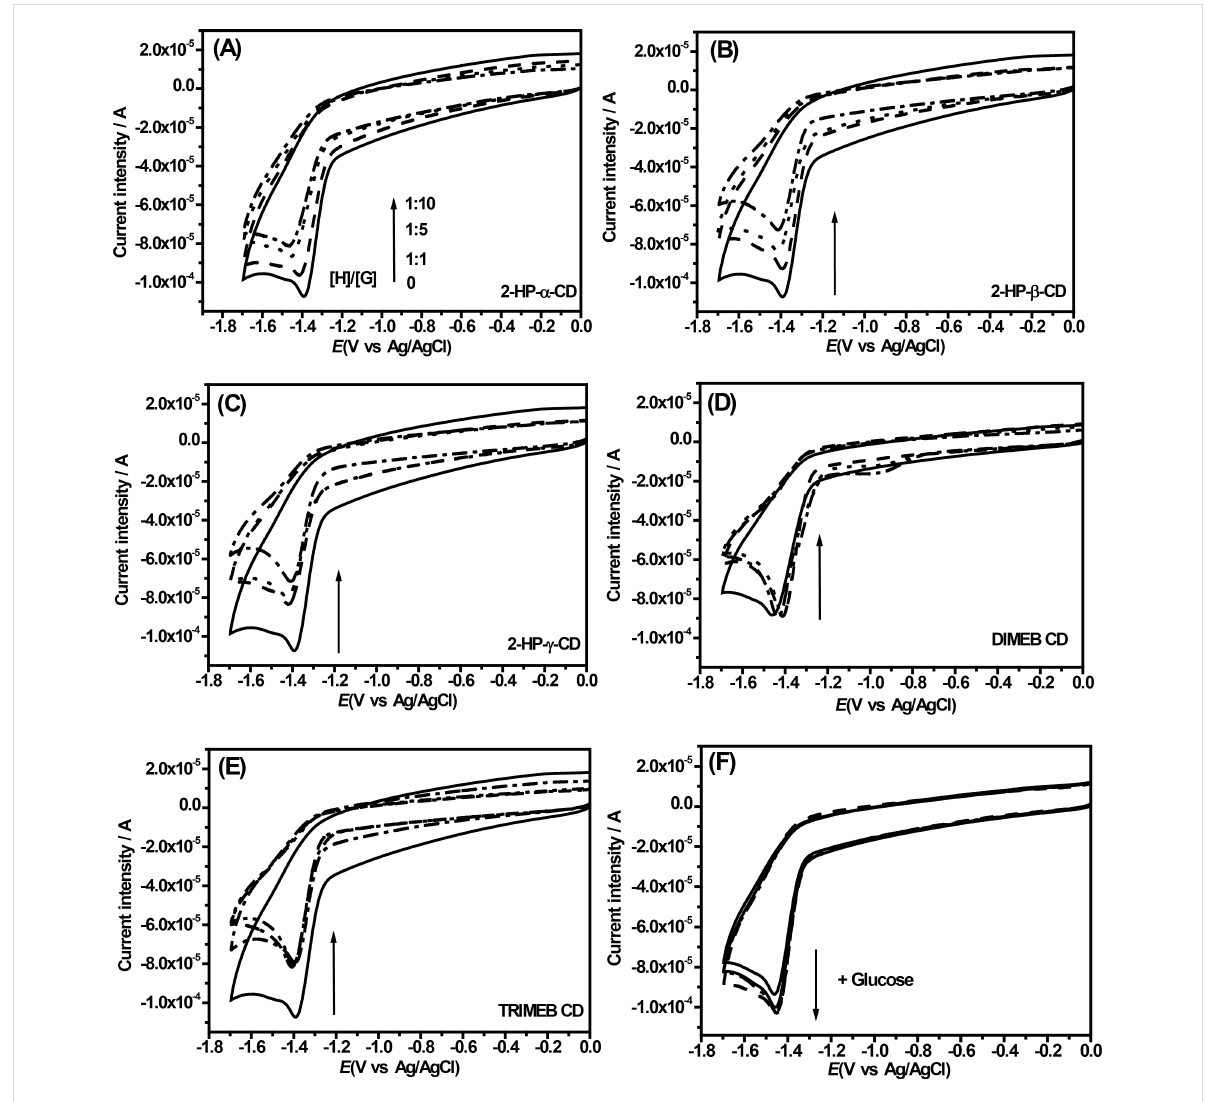
Figure 3: Cyclic voltammetry of aqueous solutions containing S 4 TdR (black solid line) in presence of increasing amounts of CDs, i.e., at molar ratios S 4 TdR/CDs of 1:1, 1:5, 1:10. Supporting electrolyte, LiClO 4 at 0.1 M. (A) S 4 TdR/2-HP- α -CD, (B) S 4 TdR/2-HP- β -CD, (C) S 4 TdR/2-HP- γ -CD, (D) S 4 TdR/DIMEB CD, (E) S 4 TdR/TRIMEB CD inclusion complexes and (F) S 4